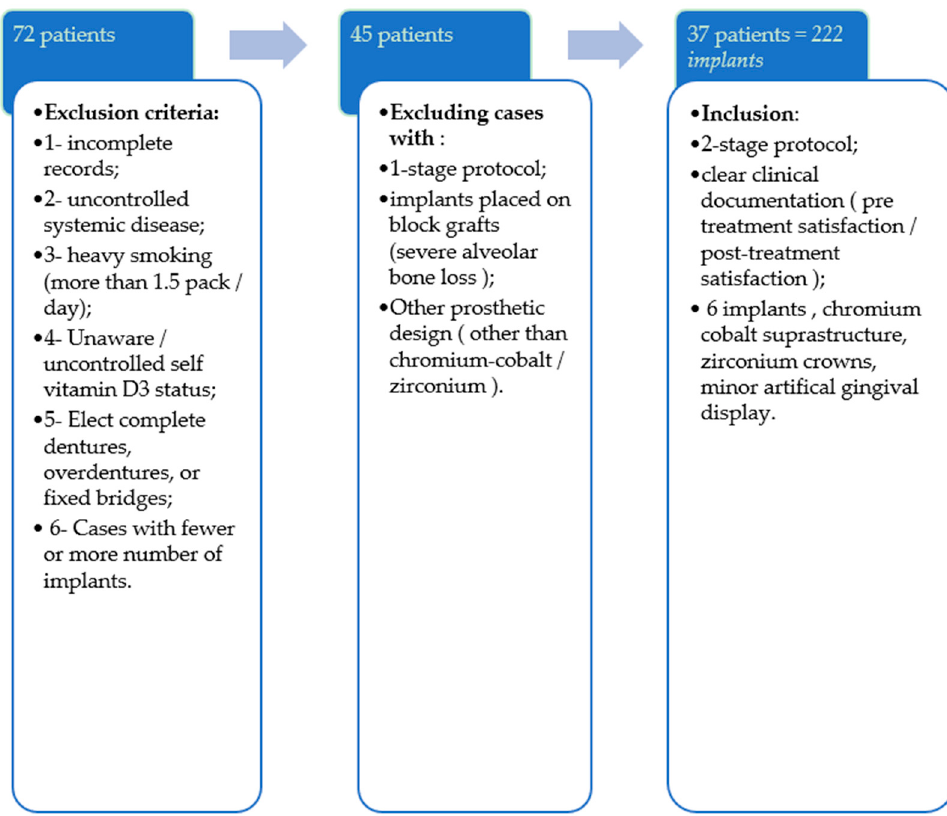
Figure 1. A flow chart presenting the case inclusion/exclusion